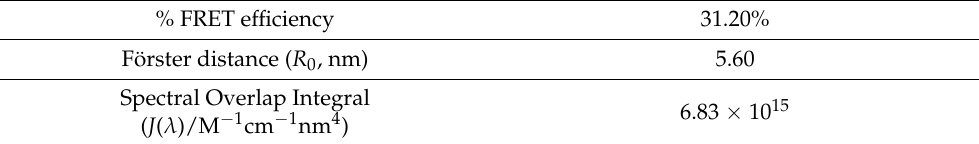
Table 1. FRET parameters: FRET efficiency, theoretical Förster distance, and spectral overlap